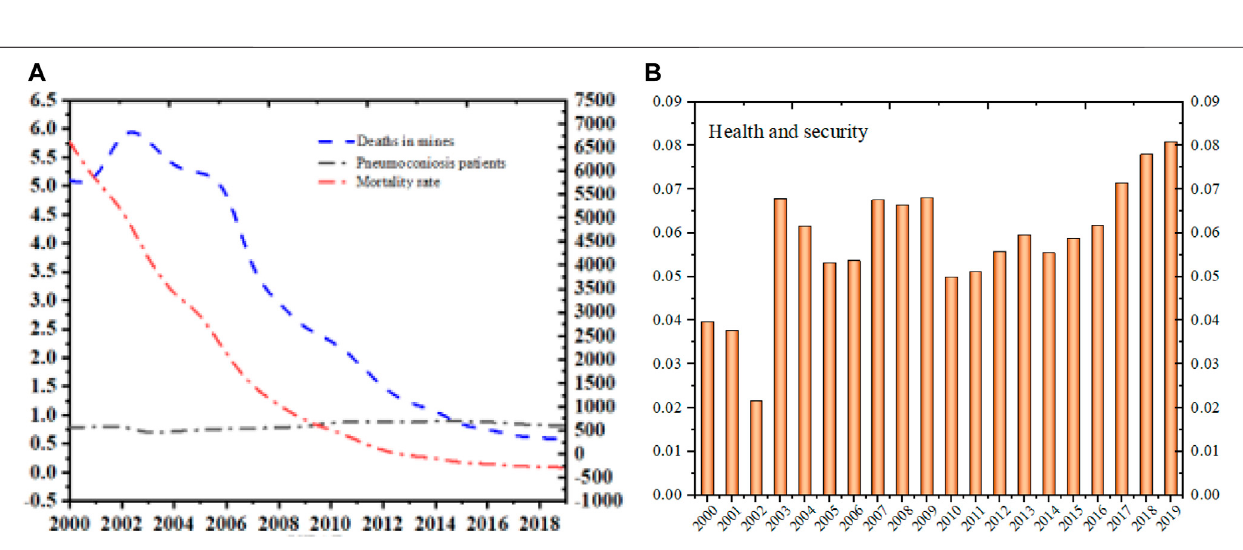
FIGURE 8 | Health and safety results from 2000 to 2019: (A) indicator value; (B) dimension